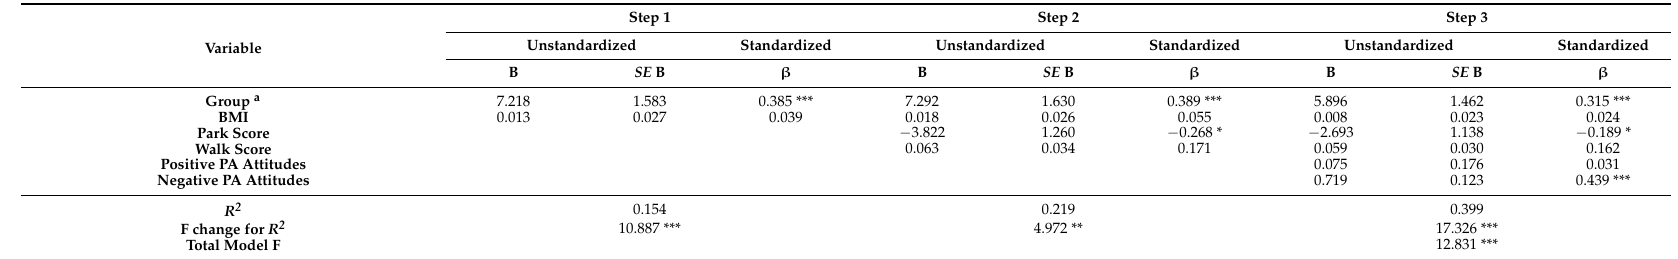
Table 4. Multiple regression model of child activity limitations.